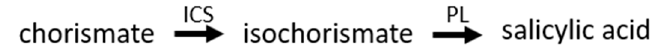
Figure 4. Salicylic acid biosynthesis pathway .